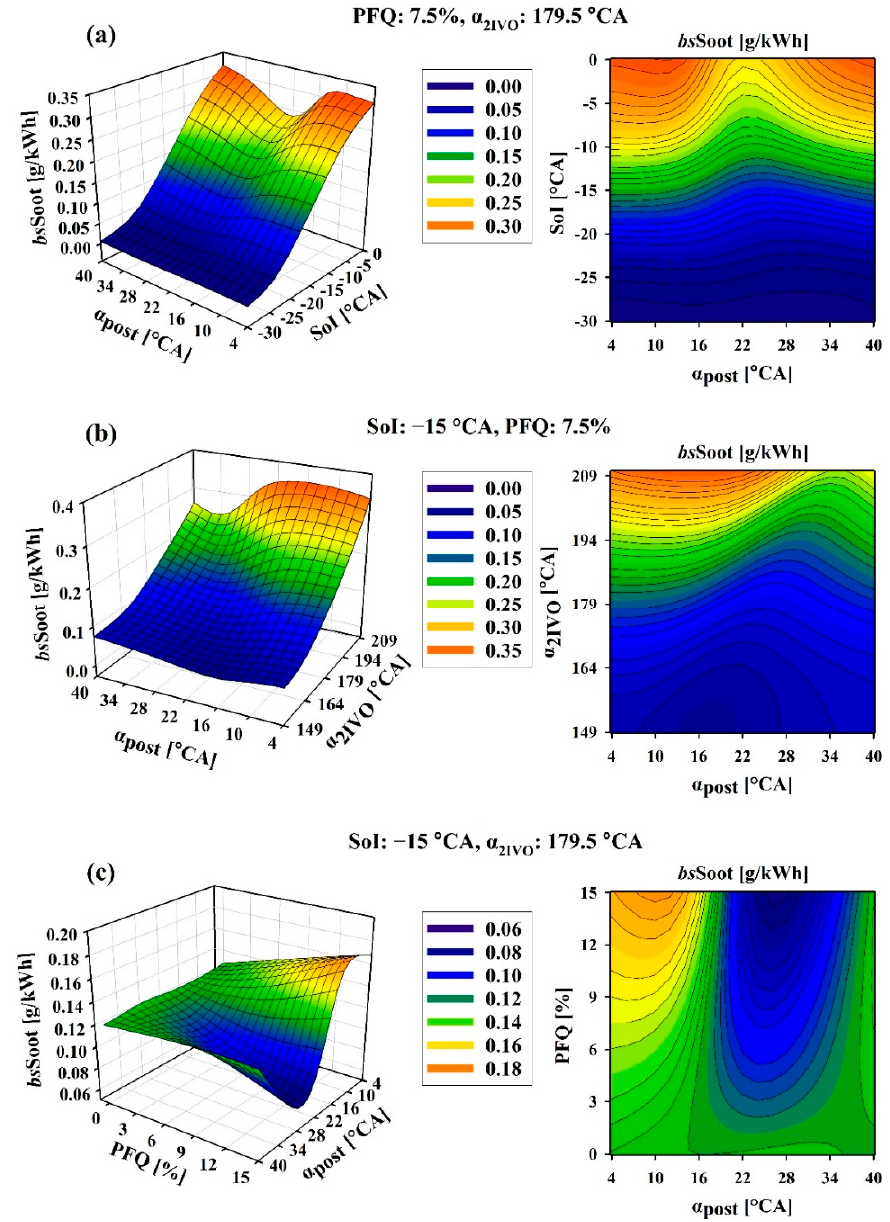
Figure 13. bsSoot response surfaces for ( a ) α post —SoI, ( b ) α post — α 2IVO and ( c ) PFQ— α post . Figure 13. bs Soot response surfaces for ( a ) α post —SoI, ( b ) α post — α